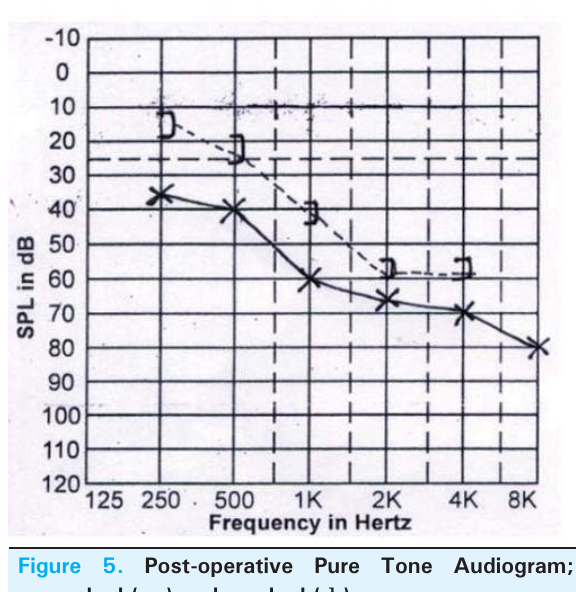
Figure 5. Post-operative Pure Tone Audiogram; unmasked ( x ) and masked ( ] ) With the increasing frequency at which vestibular schwannomas are diagnosed at an earlier stage, hearing preservation has become an important